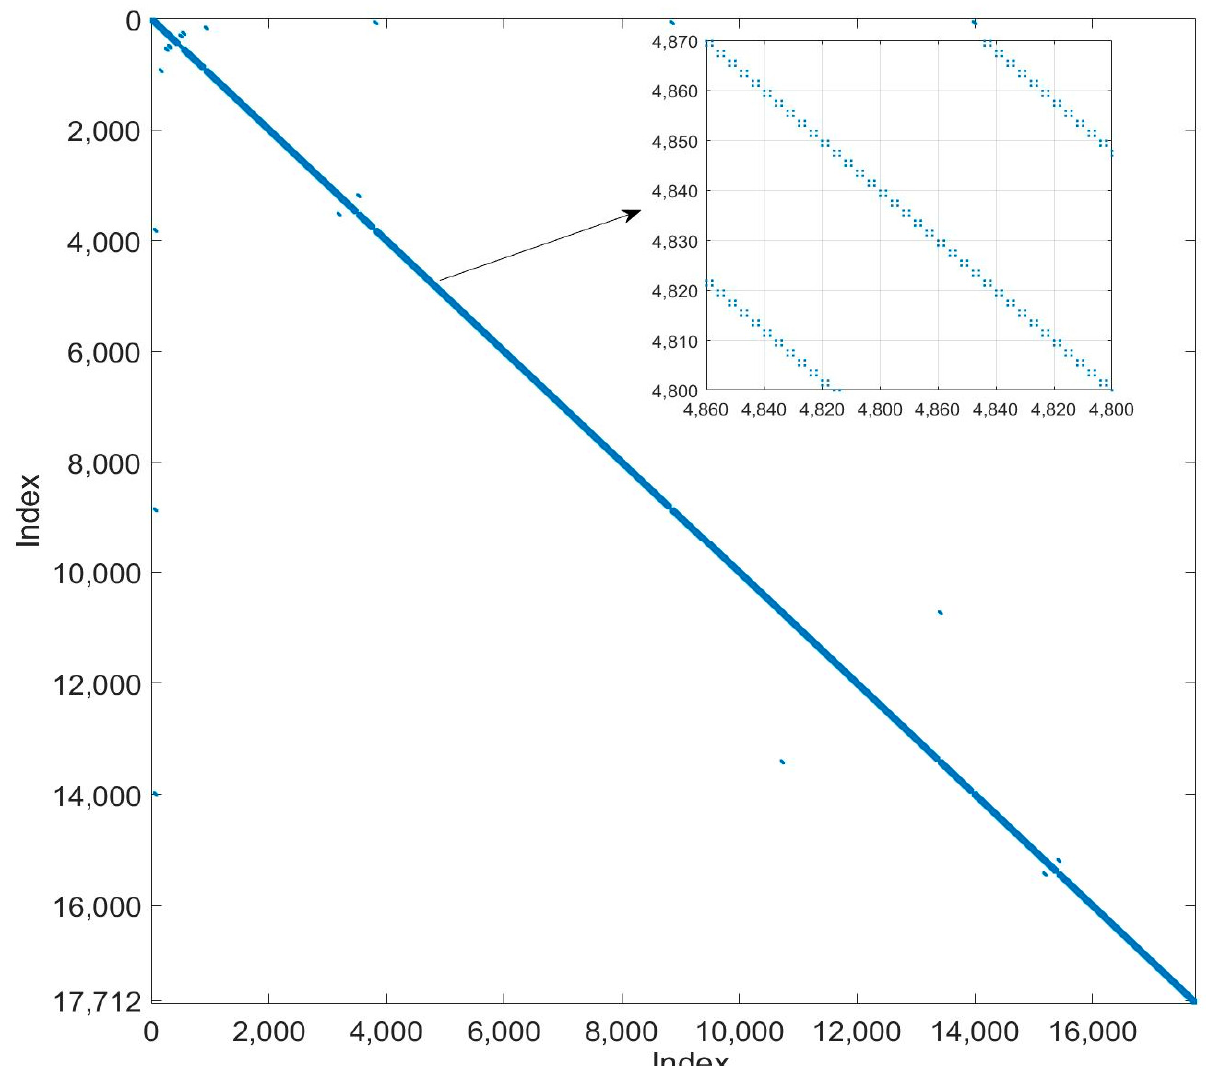
Figure 7. System Admittance matrix made from the tensor representation of nonlinear devices. For the comparison with the fixed harmonic current injection approach, three represen- tative cases were considered. These were 30% of the load nonlinear, 60%, and, finally, 90%. Figures 8–10 show the comparison between the current injection method and tensor- based harmonic analysis. The x -axis shows the connection point, and the subintervals are the considered eight harmonics (harmonic orders 3, 5, 7, 9, 11, 13, 15, and 17). The locations shown in Figures 8–10 were selected as they display nodes that are at the end of a feeder (178 and 179), those close to the supply point (185 and 186), and those midway along a long feeder (232 and 233), and the voltage distortion will differ because of their position in the